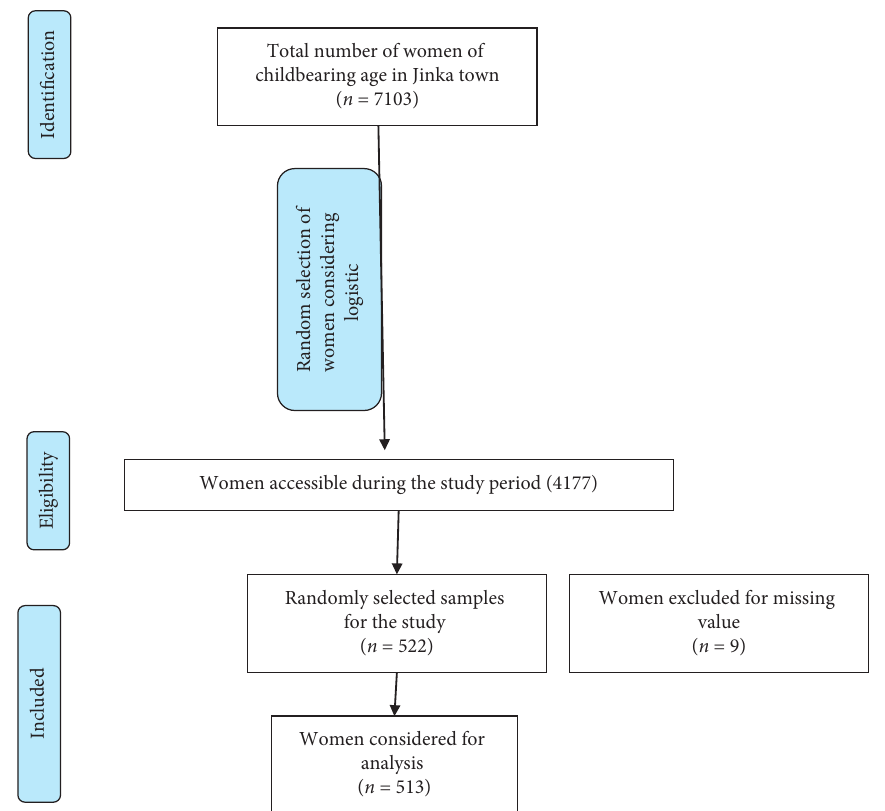
Figure 1: Flow chart for included and excluded study participants in a preconception knowledge assessment study conducted among women of reproductive age living in Jinka town, Southern